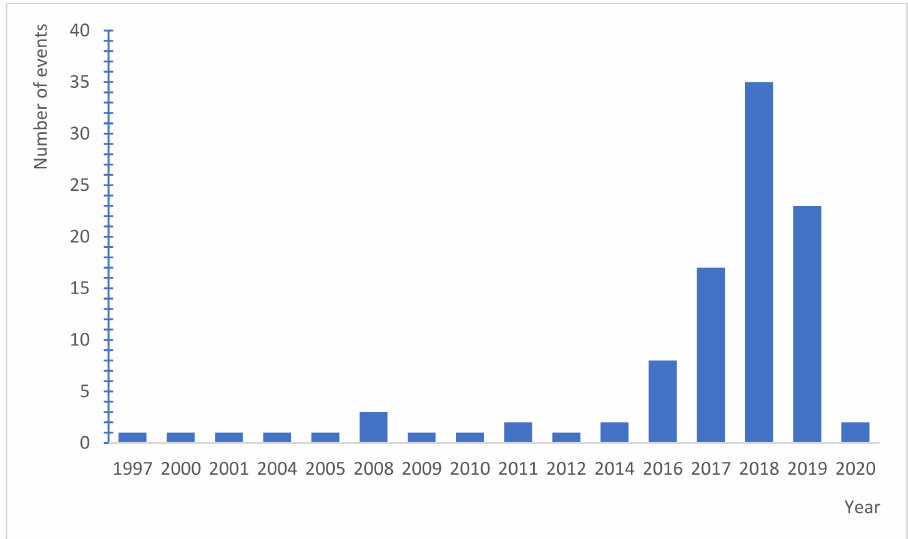
Figure 3. The number of events reported in individual